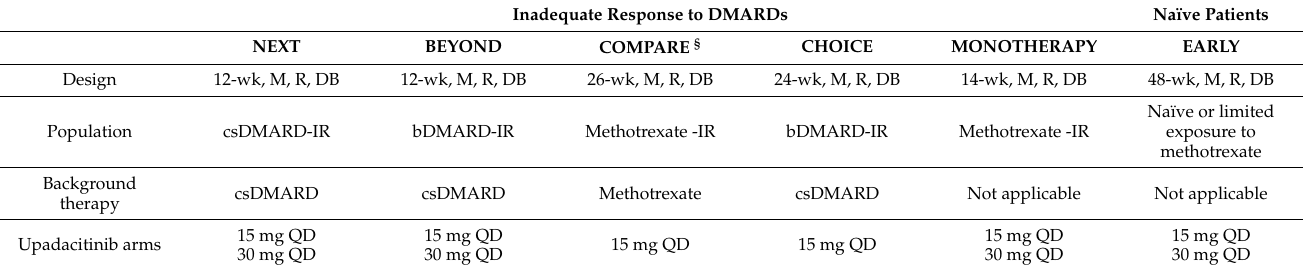
Table 2. Main characteristics of the trials included in the phase 3 SELECT program with